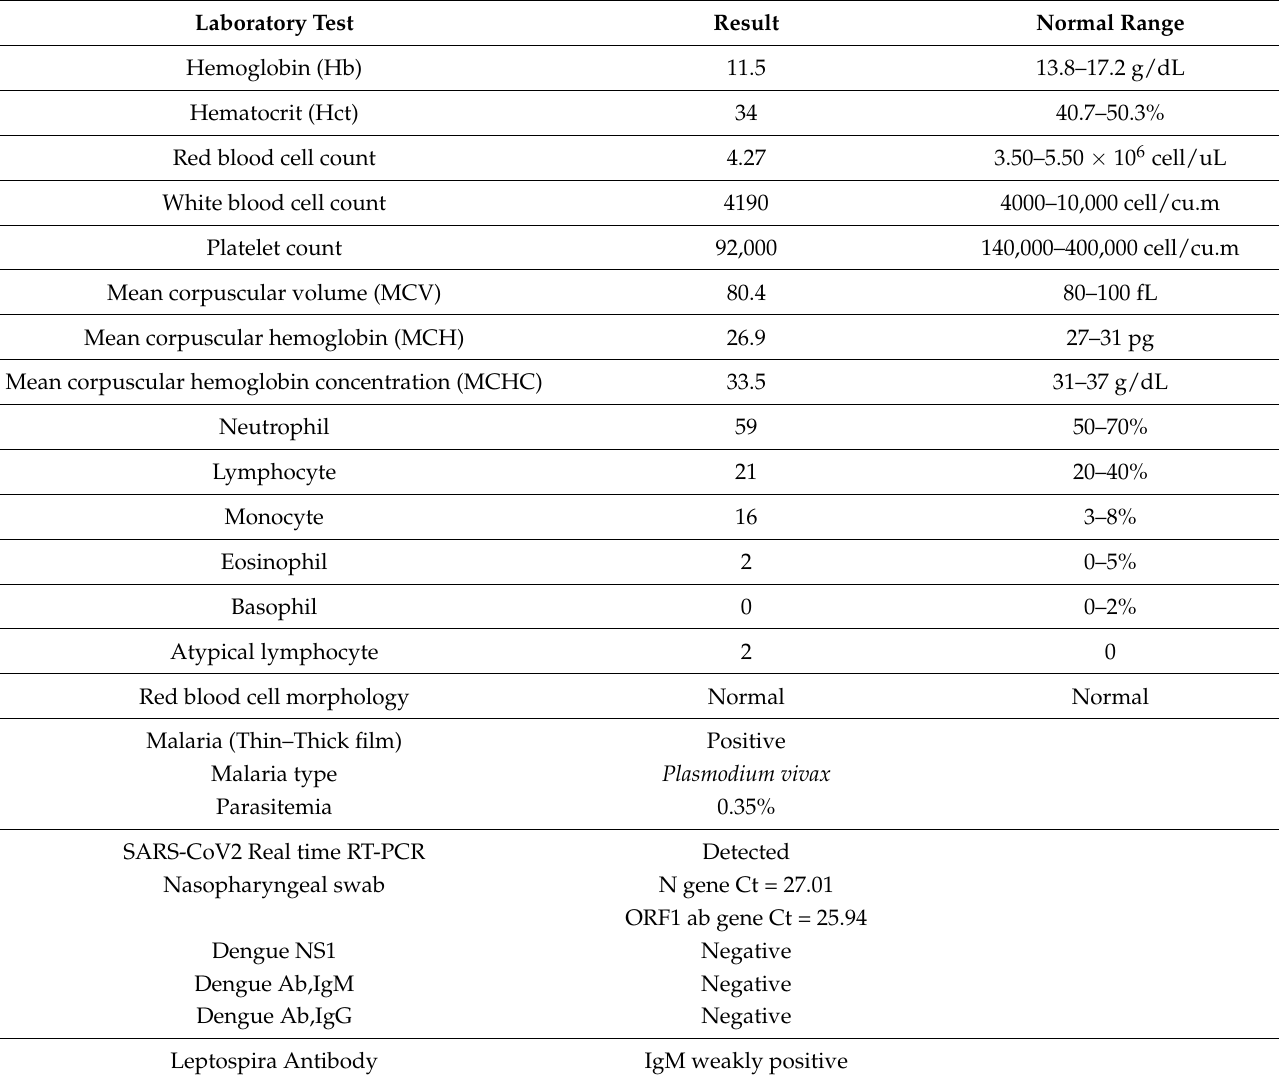
Table 1. Complete blood count and additional laboratory results at